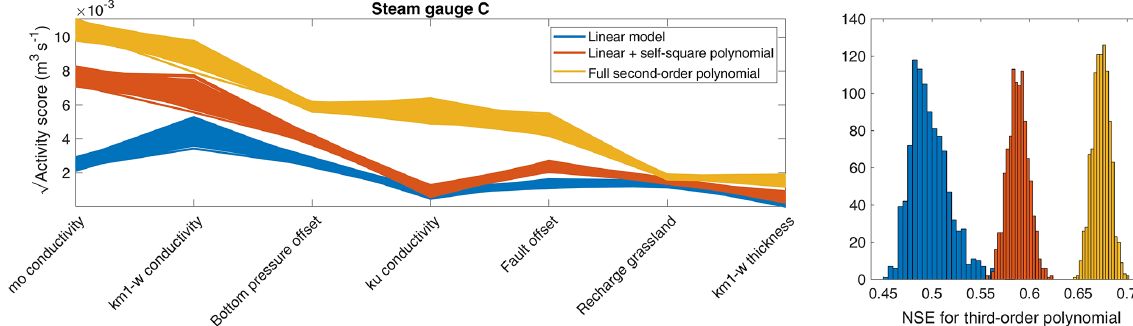
Figure 9. Square root of activity score and corresponding NSE for flow at gauge C using different approximations to compute the gradients. Each approximation is used to compute 1000 active subspaces based on a bootstrap resampling with 2500 samples from the original 4533. Only the seven most important parameters are shown in the activity-score